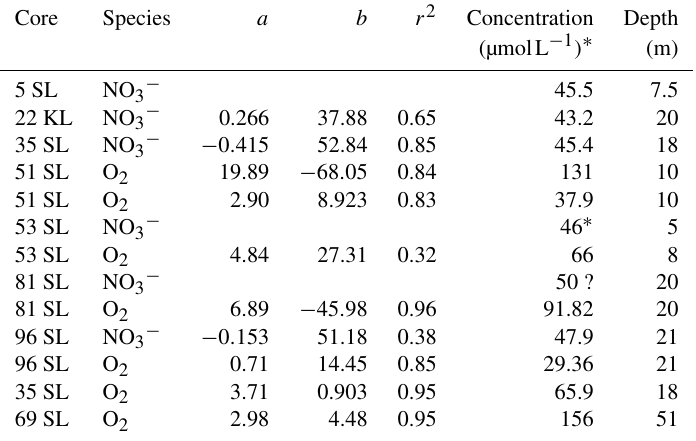
Table 2. Linear regressions and extrapolated NO 3 − concentrations at the sediment base. Regressions are based on the lower, linear part of the O 2 and NO 3 − profiles, whereby concentration in µmolL − 1 = a × (sediment depth in metres) + b